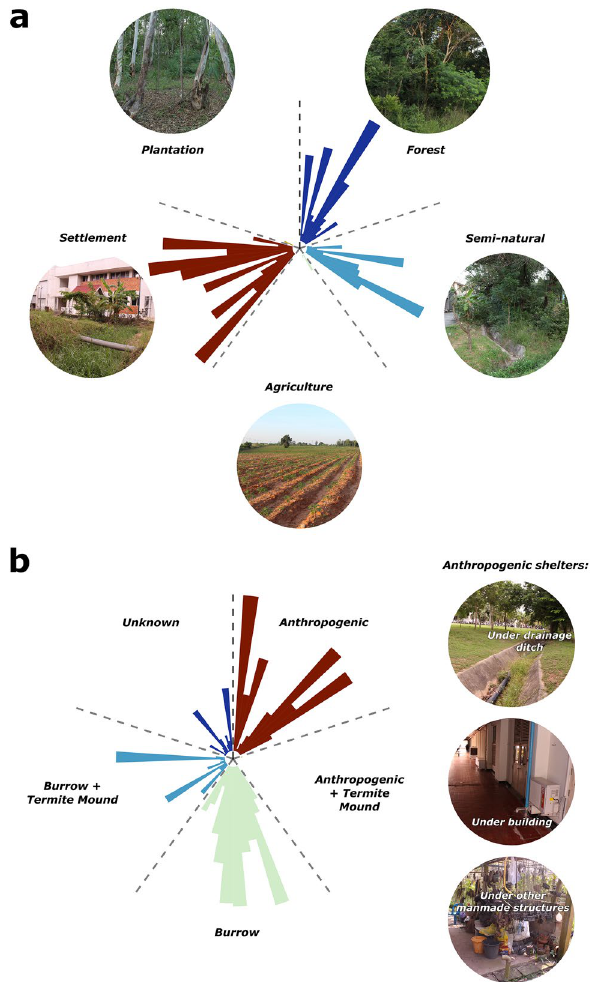
Figure 3. Proportional ( a ) habitat use and ( b ) shelter site use proportions for each telemetered B. candidus individual from Muang Nakhon Ratchasima, Thailand. This figure was created using R v.4.0.5 (https://r- proje ct. org/) in RStudio v.1.4.1106 (https:// rstud io. com/) in combination with Inkscape v.1.1.0 (https:// inksc ape.